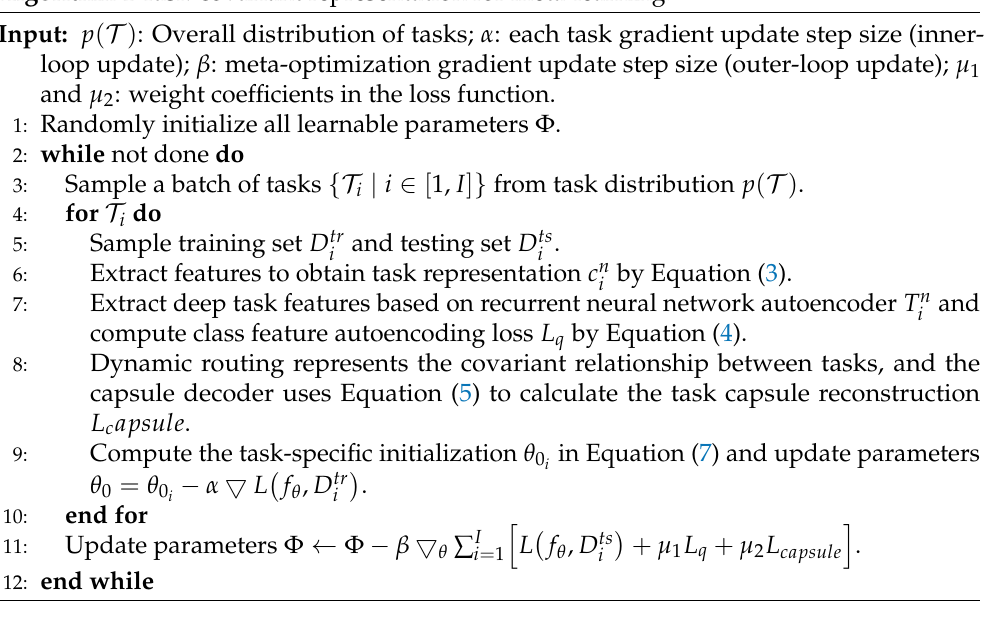
Figure 2. The framework for the task-covariant representation meta-learning algorithm. Algorithm 1 Task-covariant representation for